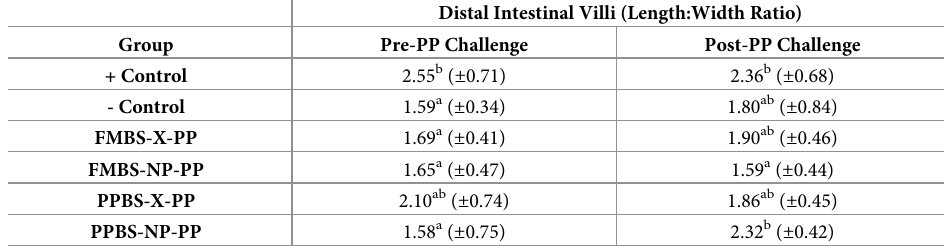
Table 4. Treatment effect on the length-to-width ratio of villi in the distal portion of the intestine.